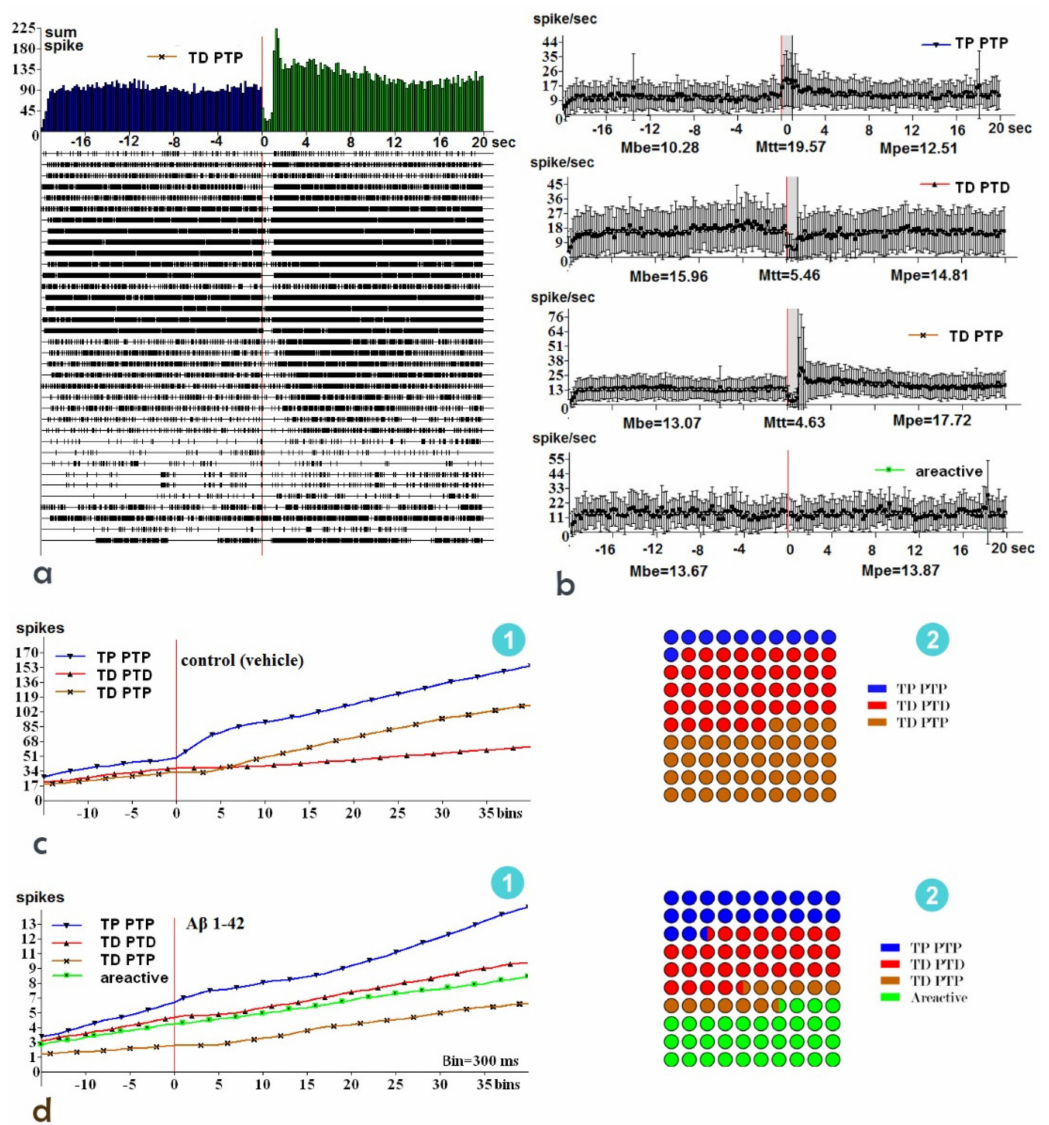
Figure 7. Peristimulus activity of hippocampal neural populations displaying TD-PTP, presented as a raster plot, and the sum of spikes for these neurons ( a ). The mean frequency histogram with processed data displaying activity during the peristimulus (M be ) and post-stimulus events (M pe ) as well as during high-frequency stimulation (tetanization time, M tt ), indicating the response type ( b ). The averaged cumulative histograms for hippocampal neural populations with specific response types in the control ( c1 ) and experimental groups ( d1 ). The distribution of response types in mentioned control ( c2 ) and experimental ( d2 ) groups